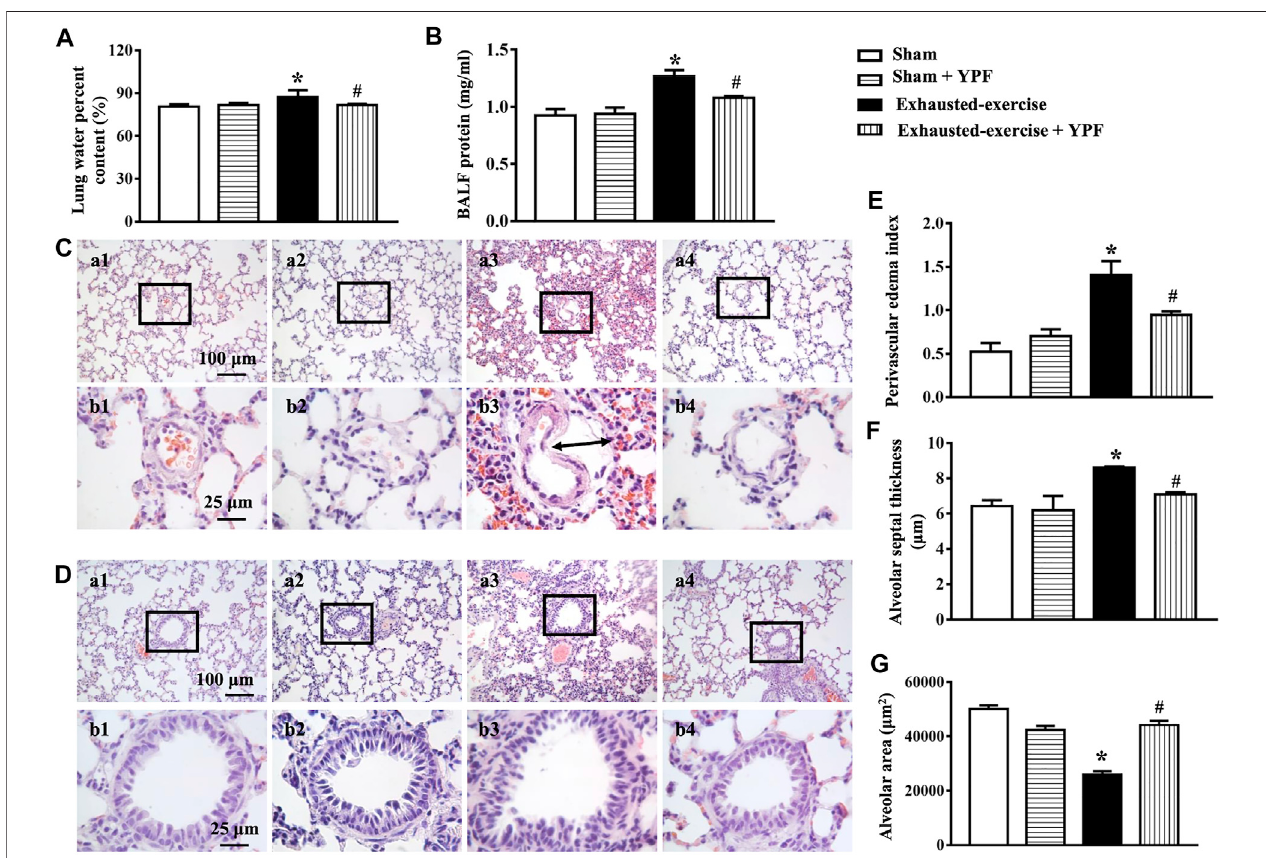
FIGURE 2 | YPF attenuates lung edema and the morphological alteration induced by exhausted exercise. (A) Lung water percent content in different groups. (B) BALFproteinconcentrationindifferentgroups. (C) RepresentativeH&Estainingimagesofratlungmicrovessels,alveolarspace,andalveolarseptum. (D) Representative H&Estainingimagesofratterminalbronchioles. (a1,b1) Shamgroup; (a2,b2) sham+YPFgroup; (a3,b3) exhausted-exercisegroup;and (a4,b4) exhausted-exercise + YPF group. Upper scale bar = 100 μ M, the ampli fi ed multiple is 100×; lower scale bar = 25 μ M, the ampli fi ed multiple is 400×. The arrow indicates perivascular edema. (E) Perivascular edema index. (F) Quantitative data for alveolar septal thickness. (G) Quantitative data for the alveolar area. Results are presented as means ± SEM ( n = 8 in A and B, and n = 4 in E – G. * p < 0.05 vs. sham; # p < 0.05 vs.